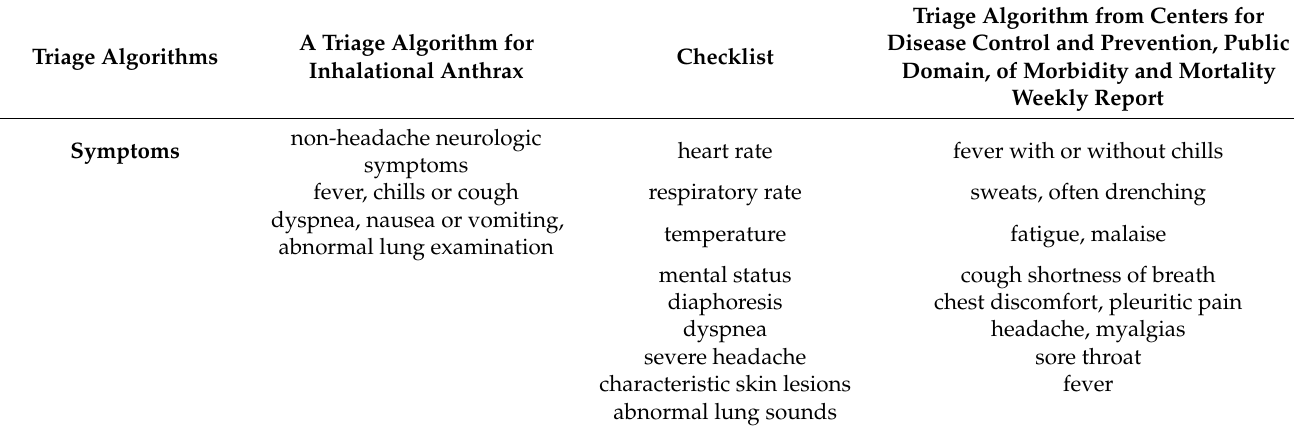
Table 3. Comparison of indicators concerned by the three triage